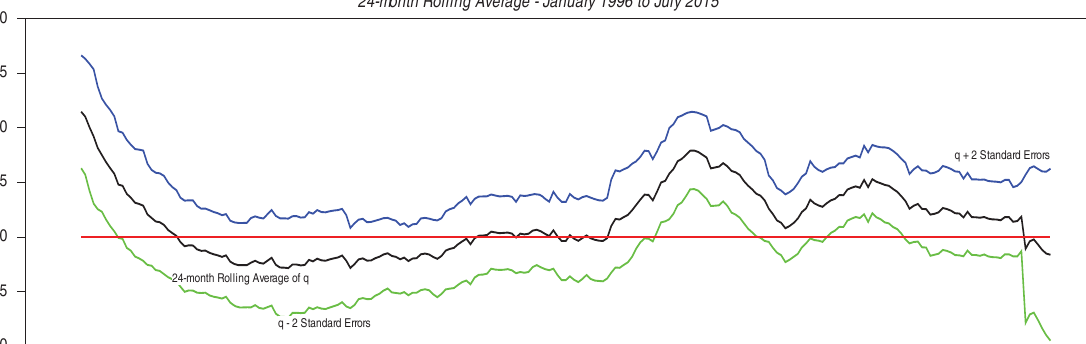
Fig. 7. Mexican peso-Chinese yuan real exchange rate